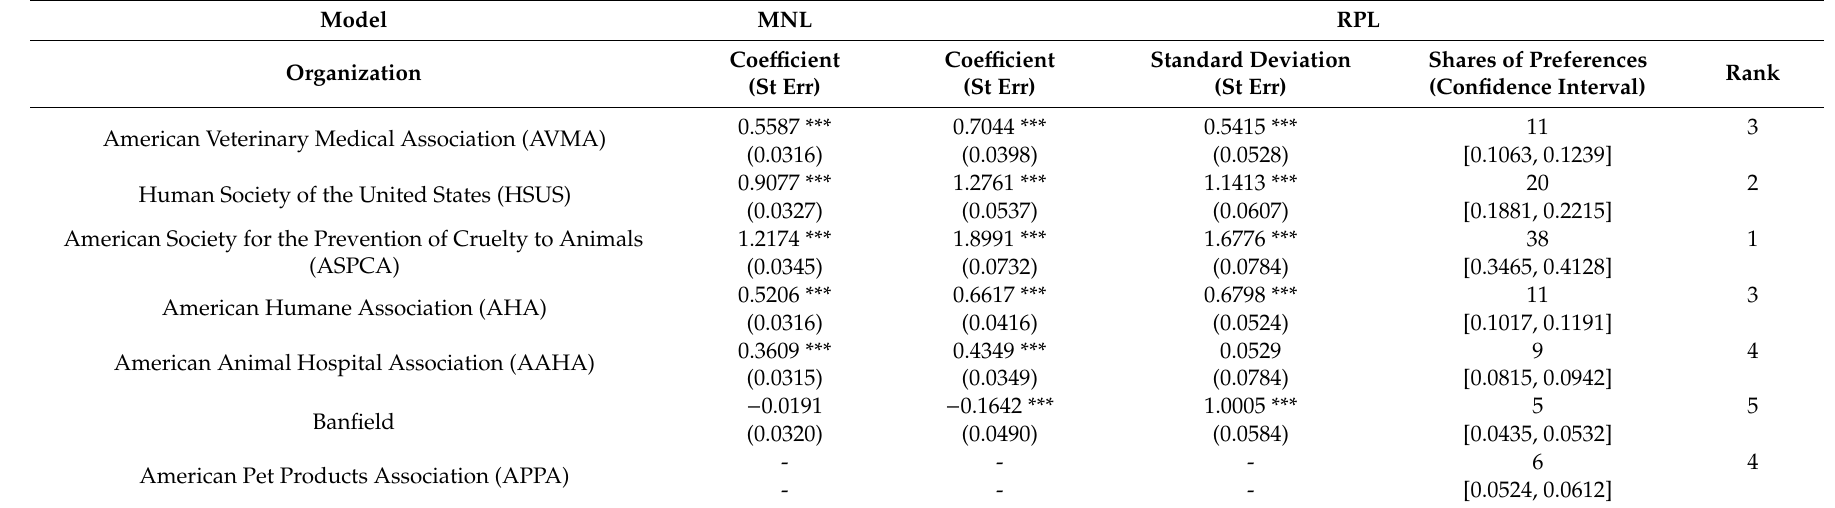
Table 7. Multinomial logit (MNL) and random parameter logit (RPL) results (n =